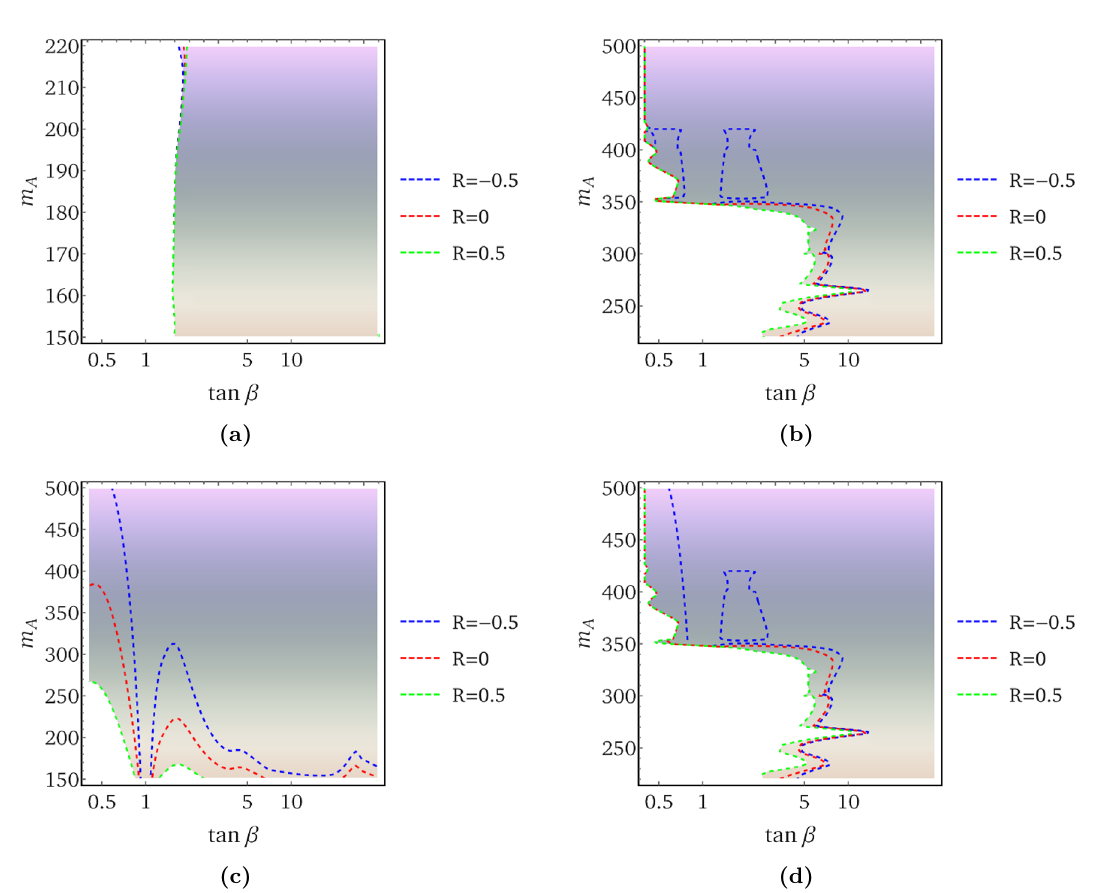
Figure 1. Bounds for Type-I Yukawa couplings. Regions ruled out by (a) A/H → ττ data, (b) combination of collider constraints, including A/H → ττ , (c) precision Higgs global fits, and (d) combination of collider bounds and global fits of Higgs precision data. Each panel shows three different R curves; the white regions of the parameter space are ruled out. In panels (b)–(d) the ruled out areas expand somewhat as R decreases, with the borders of the allowed shaded regions indicated by the corresponding contours. For R = − 0 . 5 , the area enclosed by the closed dashed blue contour in panels (b) and (d) is also ruled out. There is a different m A scale in panel (a) as compared to the other three panels because the A → γγ and A → Zh bounds are restricted to m A & 220 GeV . The color of the shaded regions bounded by the outermost contour in all figures is chosen solely for its aesthetic